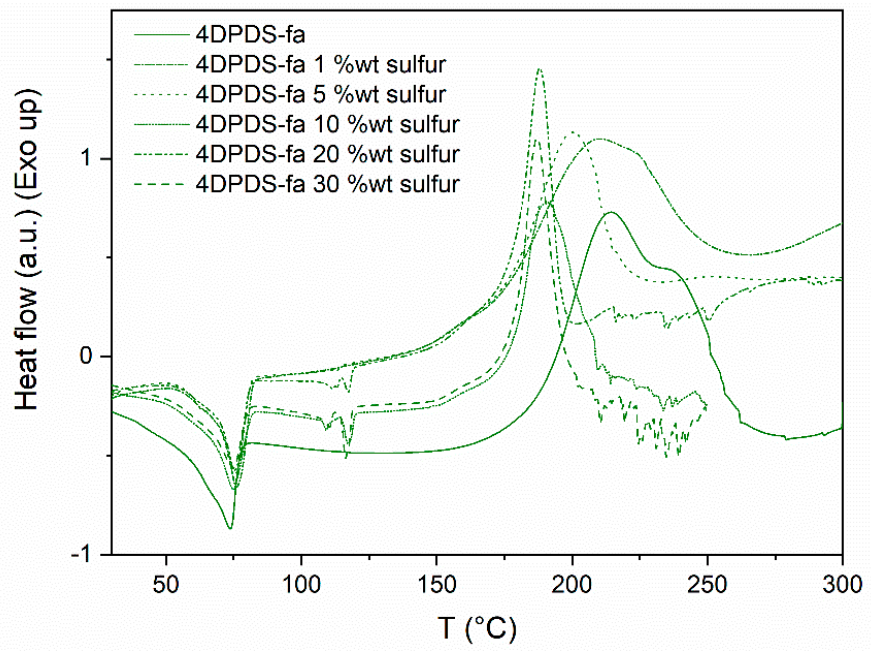
Figure A22. DSC thermogram of 4DPDS-fa, 4DPDS-fa with 1, 5, 10, 20 and 30 %wt of sulfur.